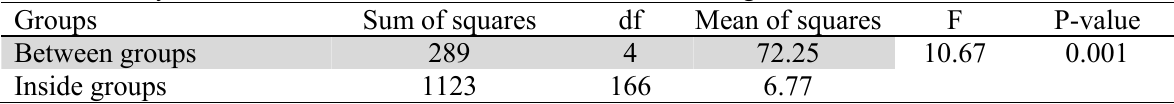
The results of Chi-Square test on the effects of various factors Problem Organizational